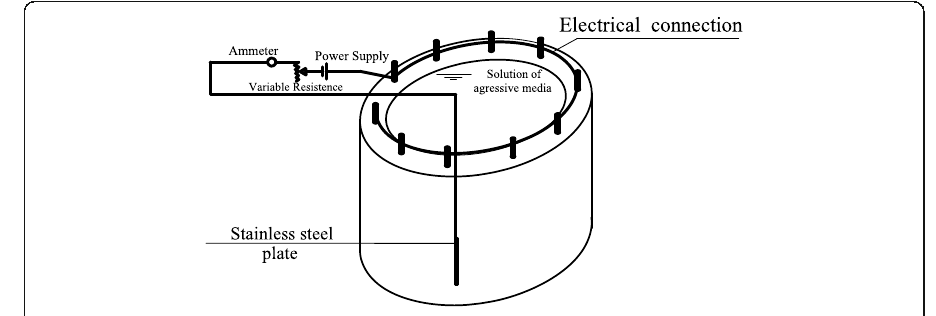
Fig. 7 Schematic representation of the accelerated corrosion